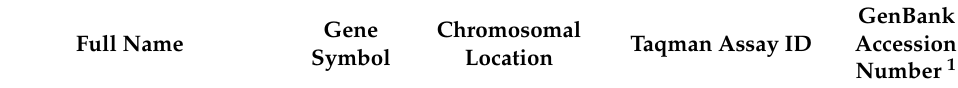
Table A1. Gene information and specifications for the individual TaqMan (Applied Biosciences) and QGP (A ff ymetrix) assays